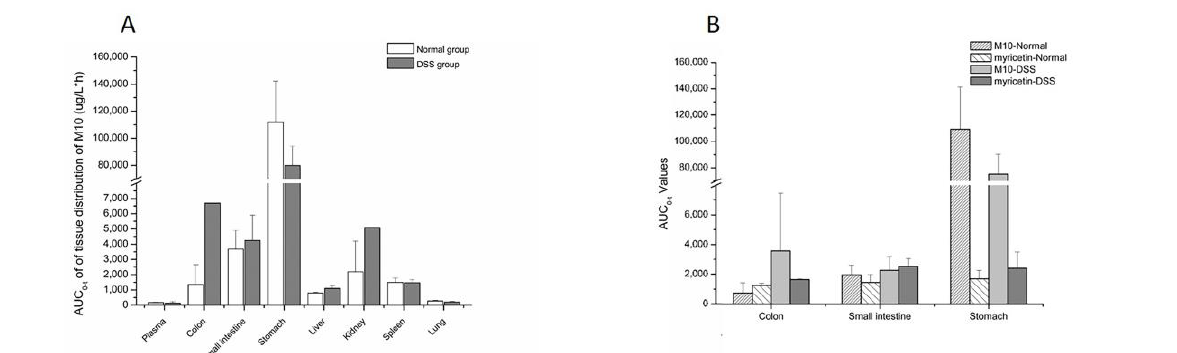
Figure 4. AUC 0-t values of M10 and myricetin in tissues. ( A ) AUC 0 – t values of M10 in tissues after oral administration of M10 (50 mg/kg) in colitis and normal mice; ( B ) the comparison of AUC 0-t values of M10 and myricetin in tissues after oral administration of M10 (50 mg/kg) in colitis and normal mice.